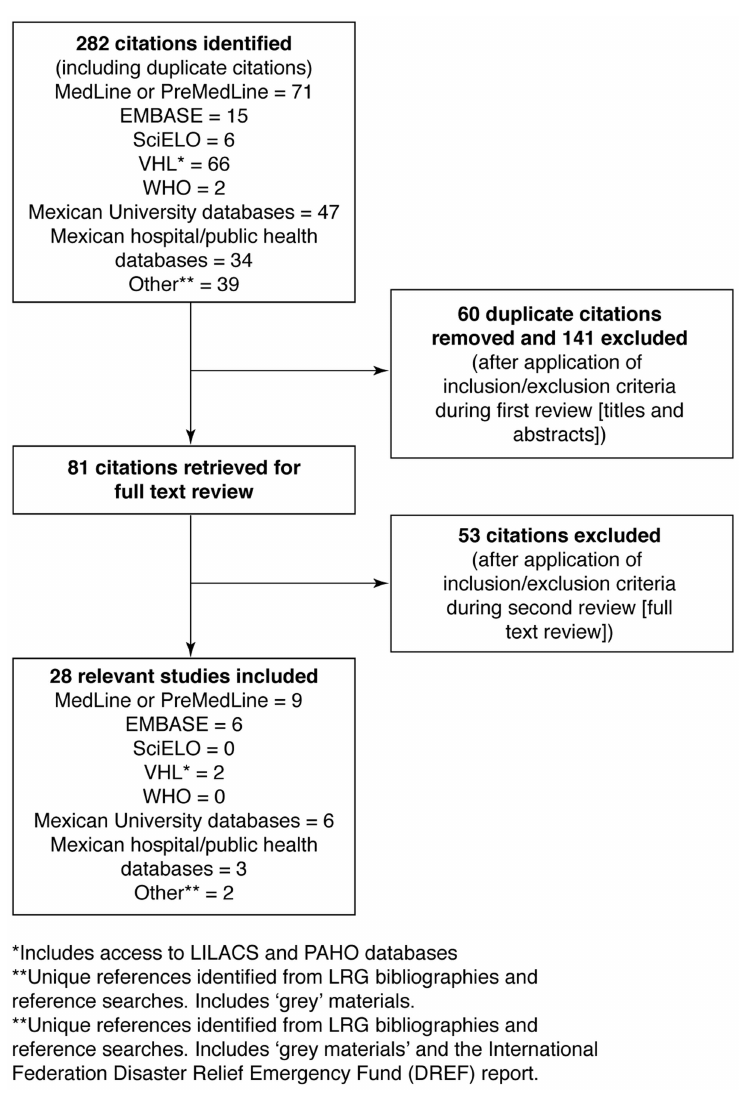
Figure 1. Evaluation of studies according to the preferred reporting items of systematic reviews and meta-analyses (PRISMA). All references identified in the online database searches were assigned a unique identification number. Following the removal of duplicates and articles that did not satisfy the inclusion criteria from review of the titles and abstracts, the full papers of the first selection of references were retrieved either electronically or in paper form. A further selection was made based on review of the full text of the articles.